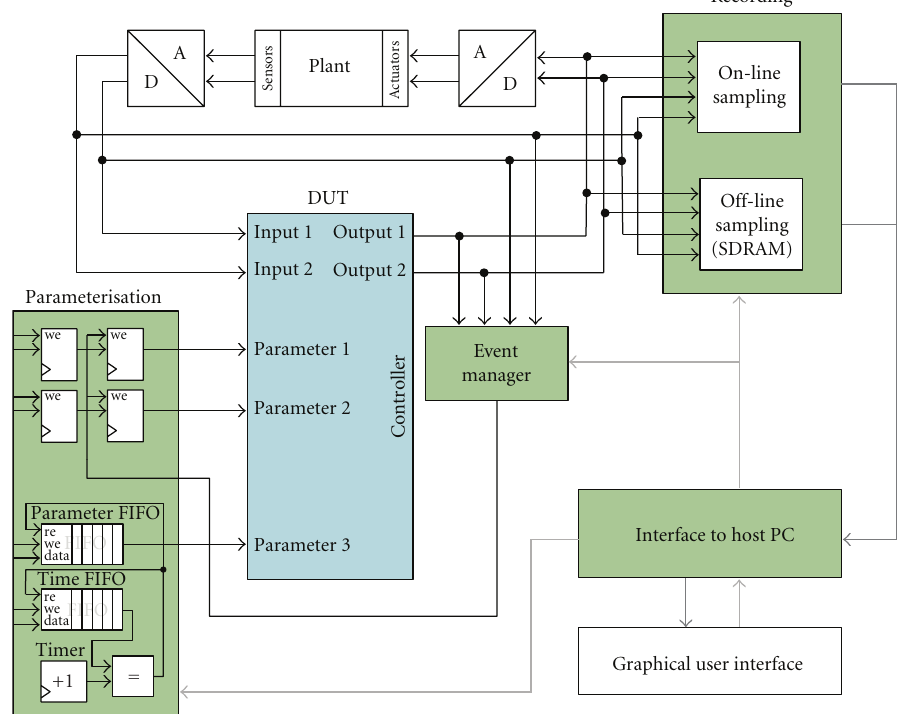
Figure 4: Structure of a real-time FPGA-in-the-Loop scenario utilizing